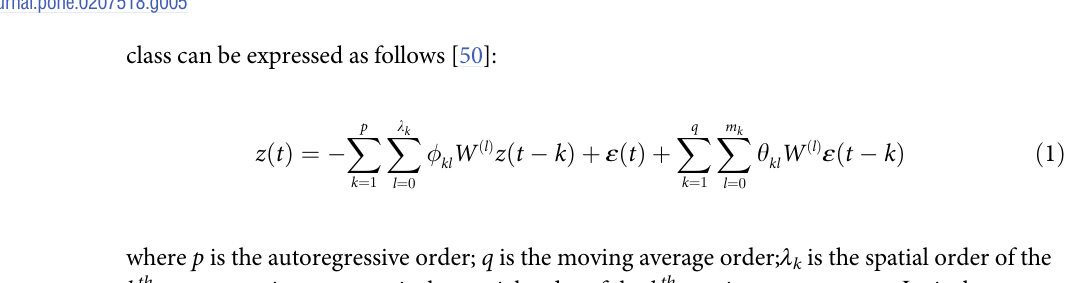
Fig 5. Distribution pattern of HFRS according to Moran’s Index from 2005–2014. Each point represents the Moran’s I value for a specific year. All of the points are joined to indicate the trend of Moran’s I for the HFRS incidence in Hubei Province.